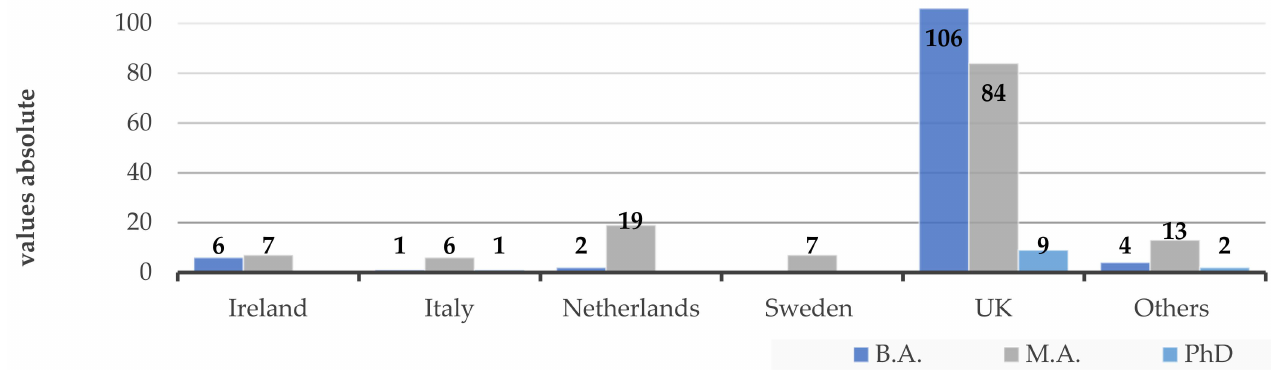
Figure 19. Locations in Europe to study DCH ( n = 267, investigated in 2021). At all levels, DCH is mostly connected to humanities disciplines (total 141); arts, design, and architecture (total 83); and social sciences (total 79). In addition, applied sciences, business management, computer science and IT, hospitality, leisure and sports, as well as journalism and media are relevant sub-disciplines where DHC is assigned (c.f. Figure 20).